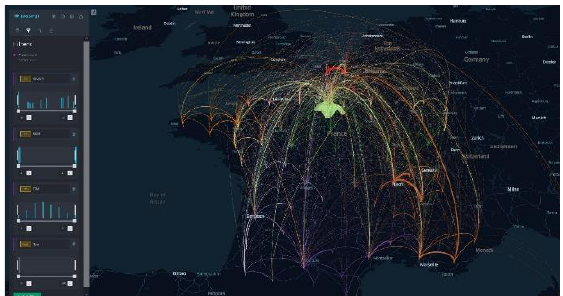
Figure 4 . Kepler.gl interface